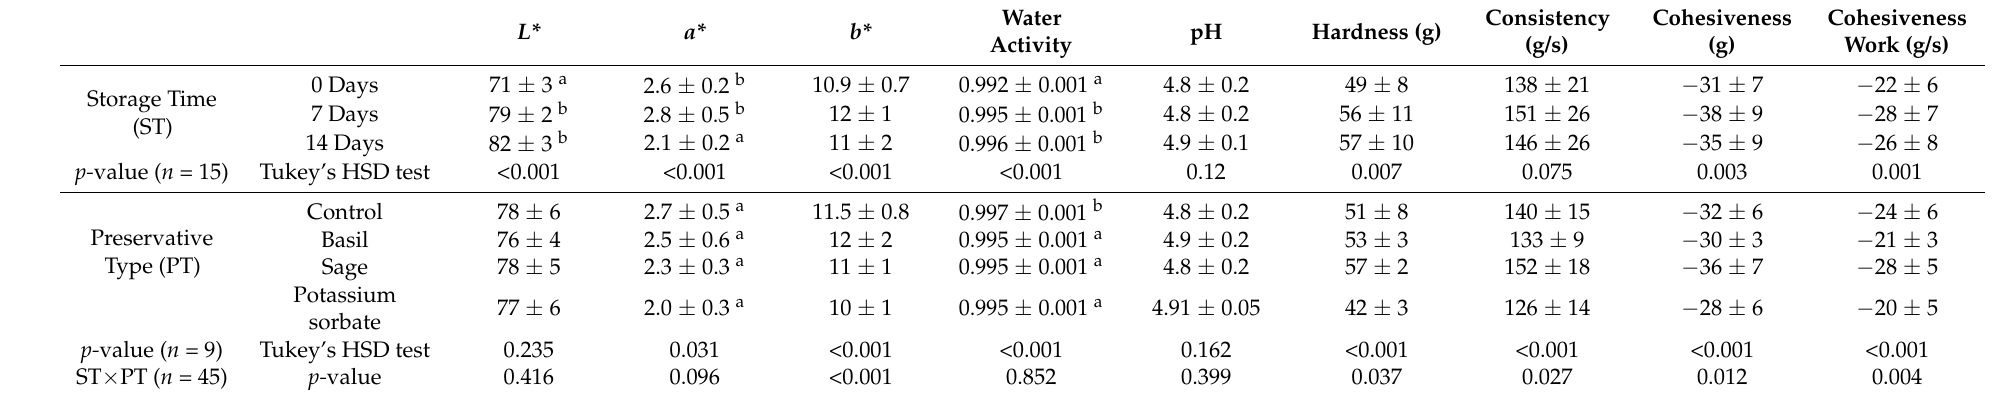
Table 2. Physicochemical parameters of the yogurts incorporated with different